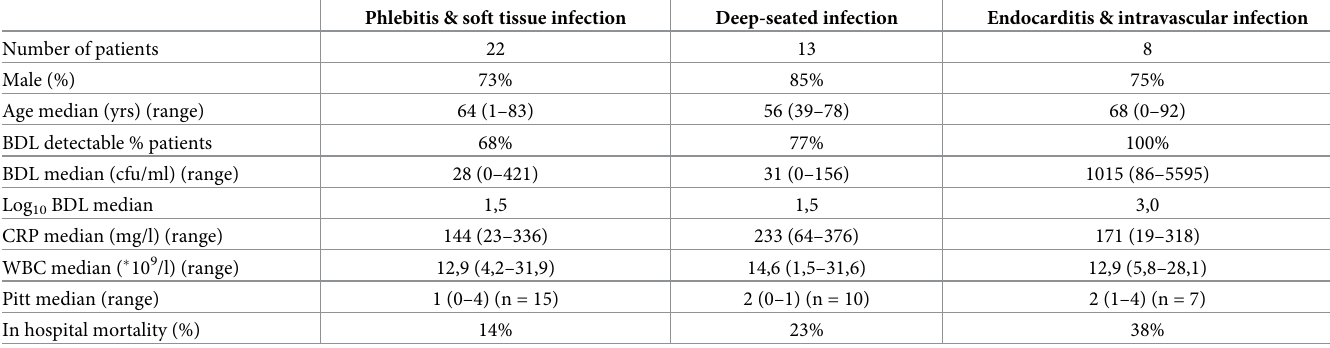
Table 1. Patient characteristics and